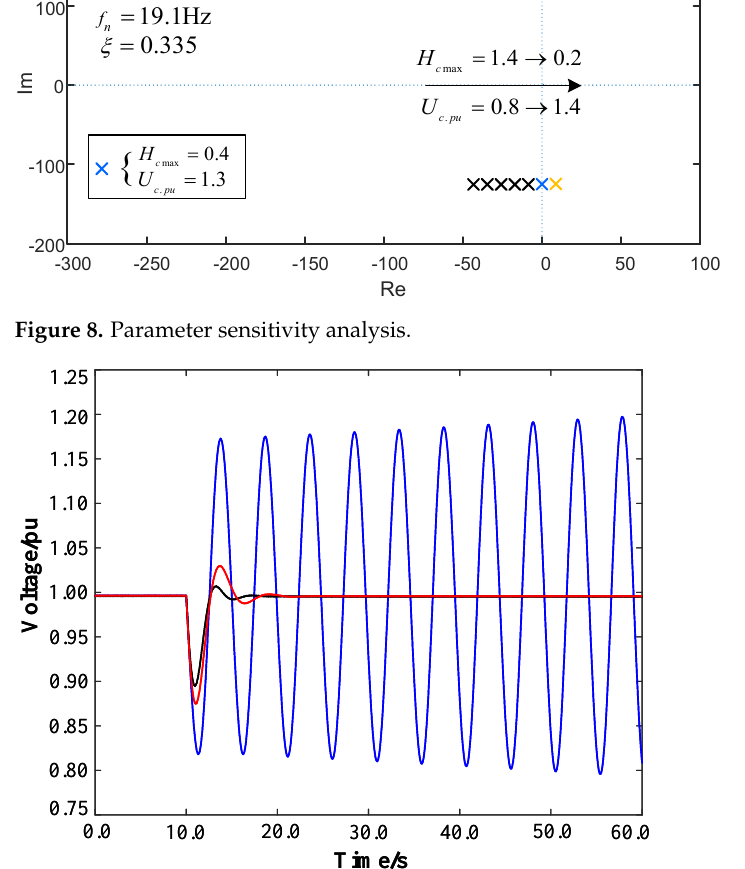
Figure 9. Time domain simulation result. Blue, red and black curves represent H cmax = 0.4, H cmax = 0.6 and H cmax = 0.9